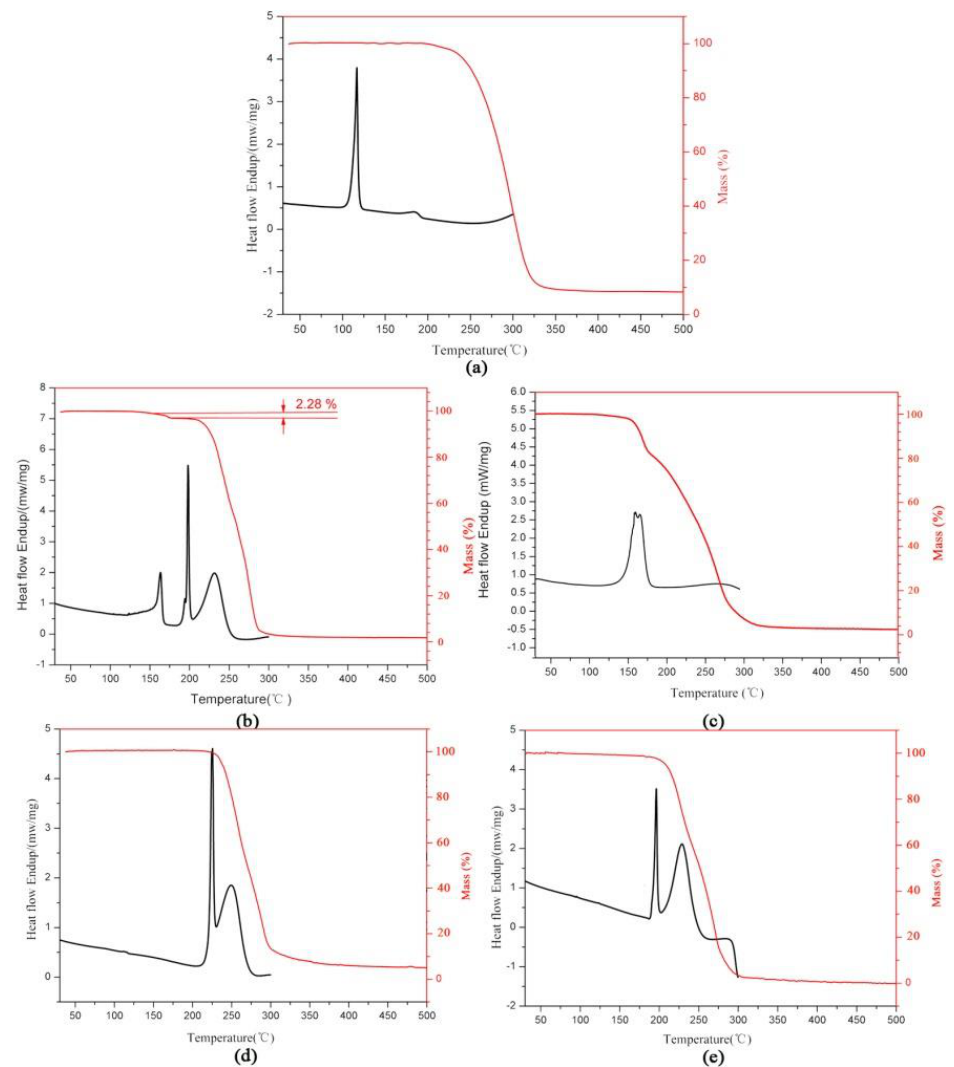
Figure 6. DSC (black) and TGA (red) curves of VOT and its salts: ( a ) VOT, ( b ) VOT-23BA-H 2 O, ( c ) VOT-24BA-TOL, ( d ) VOT-25BA, and ( e ) VOT-26BA. The DSC thermogram of VOT-25BA exhibited a sharp endothermic peak at 224 TGA curve of VOT-25BA began to decompose at 206 accompanied by the decomposition